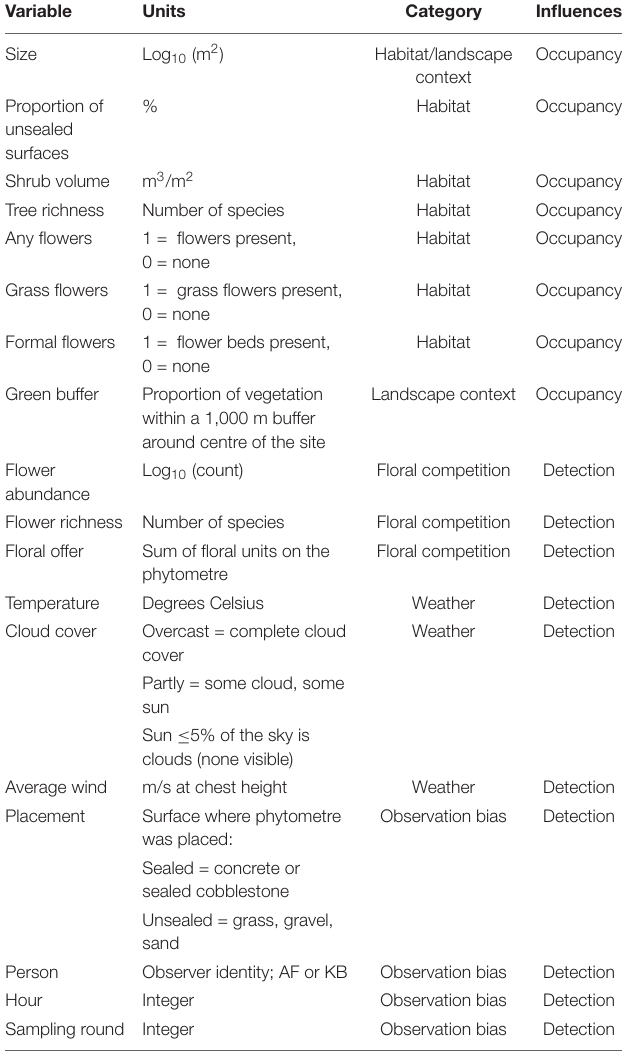
TABLE 2 | Variables used in occupancy-detection modelling, the category of variation they explain and whether they are expected to influence probability of interaction (detection) or occupancy on the